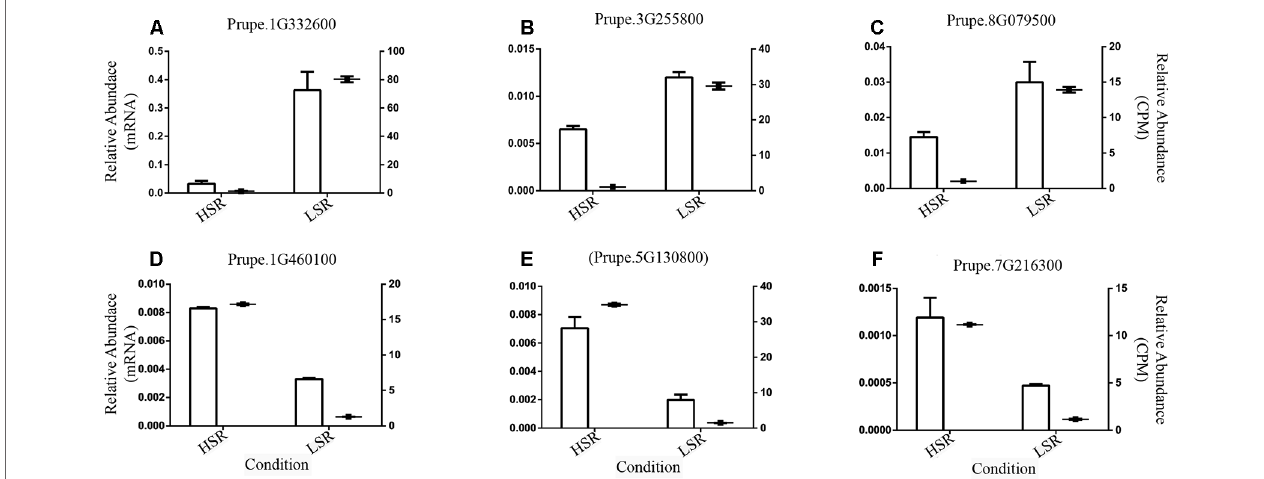
FIGURE 6 | Validation of six differentially expressed (DE) genes randomly selected; identified in the comparison between LSR and HSR siblings; using real-time (qPCR) experiments at harvest. Genes are (A) RNA-dependent RNA polymerase ( Prupe.1G332600 ); (B) Cyclin-like family protein ( Prupe.3G255800 ); (C) Indole-3- acetic acid-induced protein ARG7 ( Prupe.8G079500 ); (D) Unknown Protein Function ( Prupe.1G460100 ); (E) Unknown Protein Function ( Prupe.5G130800 ); and (F) Inositol oxygenase 4 ( Prupe.7G216300 ). The TEF2 gene (possible Translation elongation factor 2 gene) was used as a reference gene, and gene expression was expressed as relative expression. The relative abundance based on qPCR (Y-left axis) was compared with the relative abundance of normalized gene expression determined by RNA-Seq experiment (Y-right axis); both values are respectively represented as bar and point, and the standard deviation was also plotted.